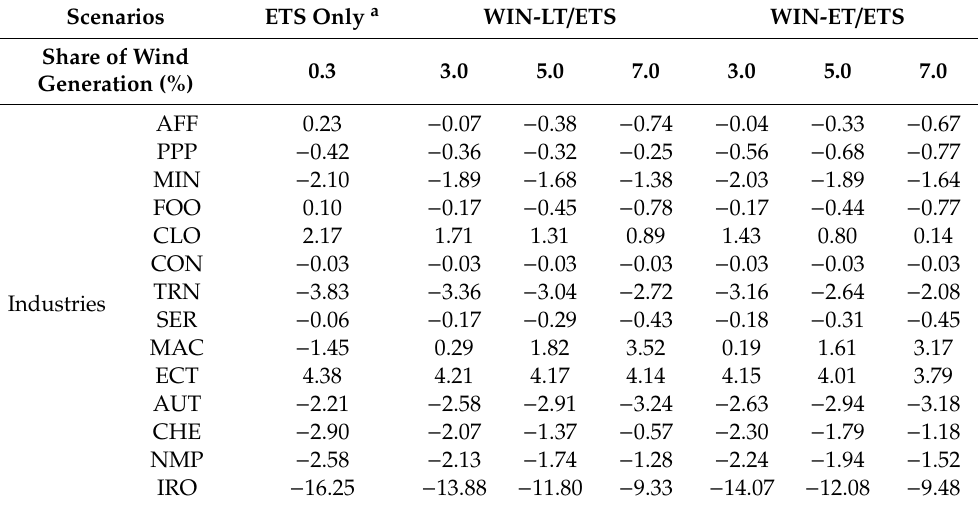
Note: a This column indicates the situation when the ETS is implemented without renewable expansion policy. Table 15. Changes in output by industry according to the increase in the share of wind generation with emission regulations (% changes in output from the base